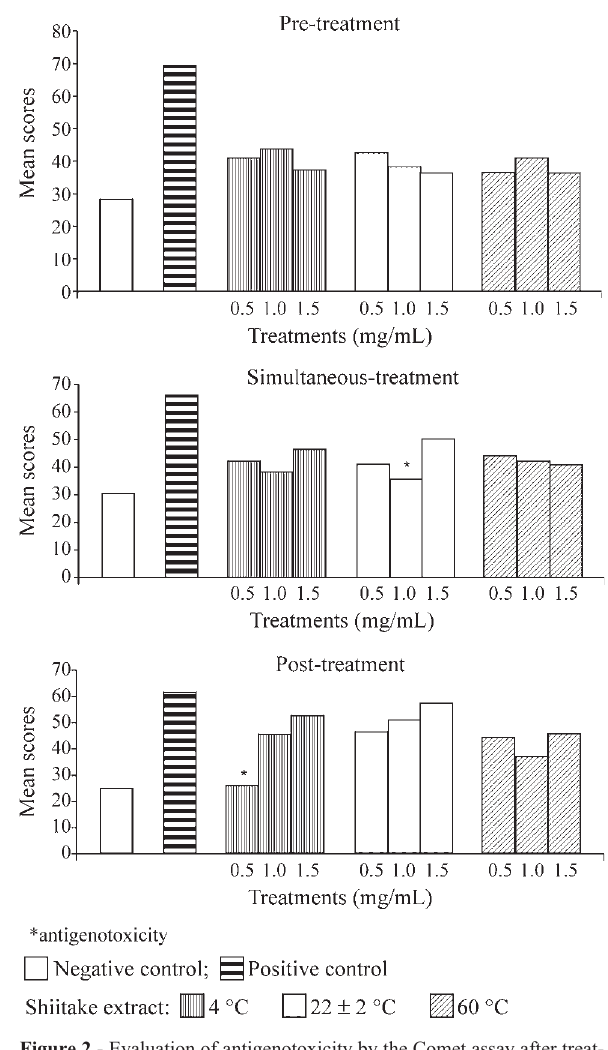
Figure 2 - Evaluation of antigenotoxicity by the Comet assay after treat- ment of HEp-2 cells with three aqueous extracts of shiitake (0.5, 1.0 and 1.5 mg/mL) prepared at three different temperatures (4, 22 ± 2 and 60 °C). Three different protocols were used: simultaneous-treatment; pre-treat- ment and post-treatment. Data represents Comet assay mean